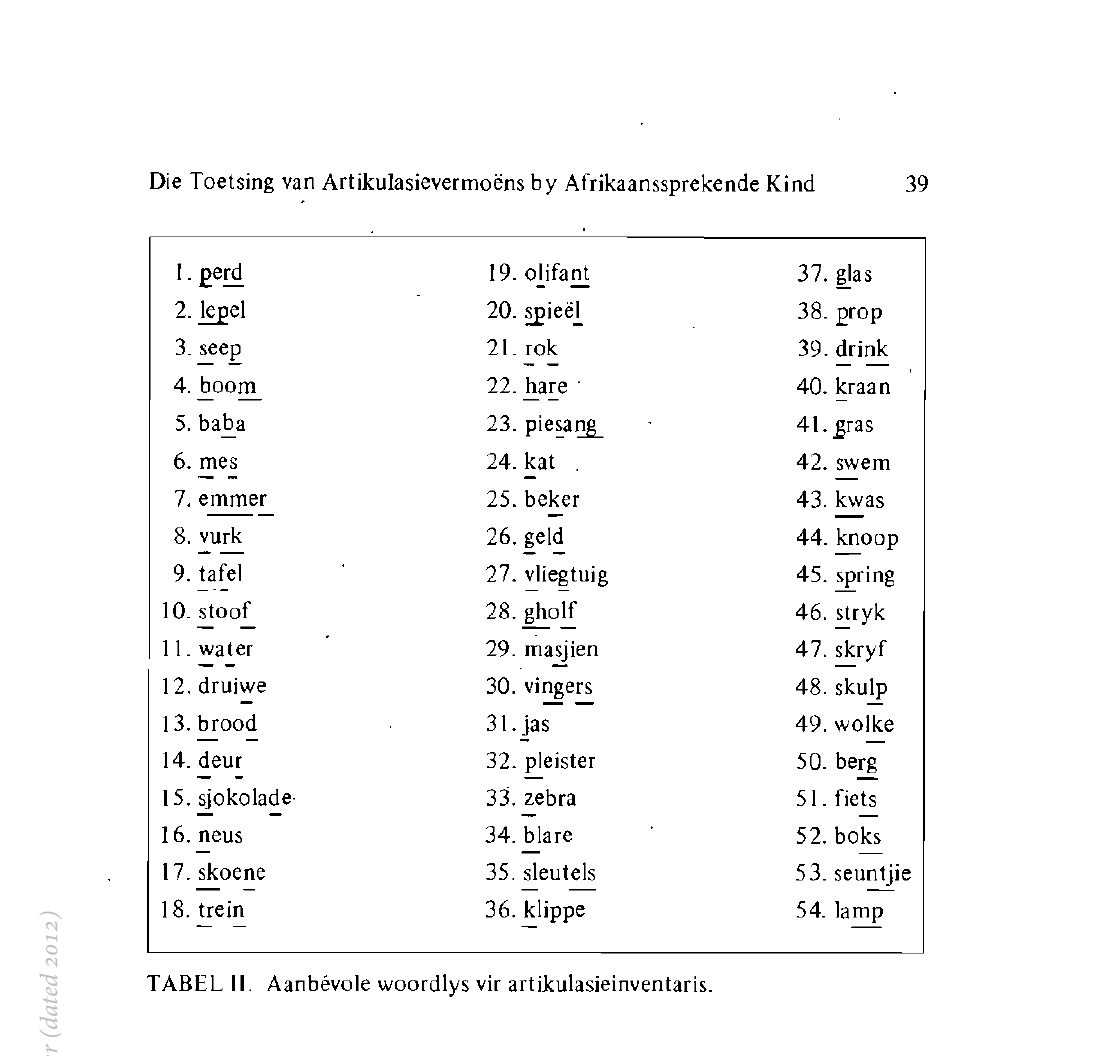
TABEL II. Aanbevole woordlys vir